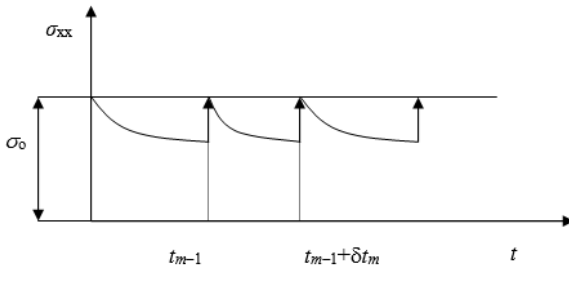
Figure 5. Correction of boundary condition